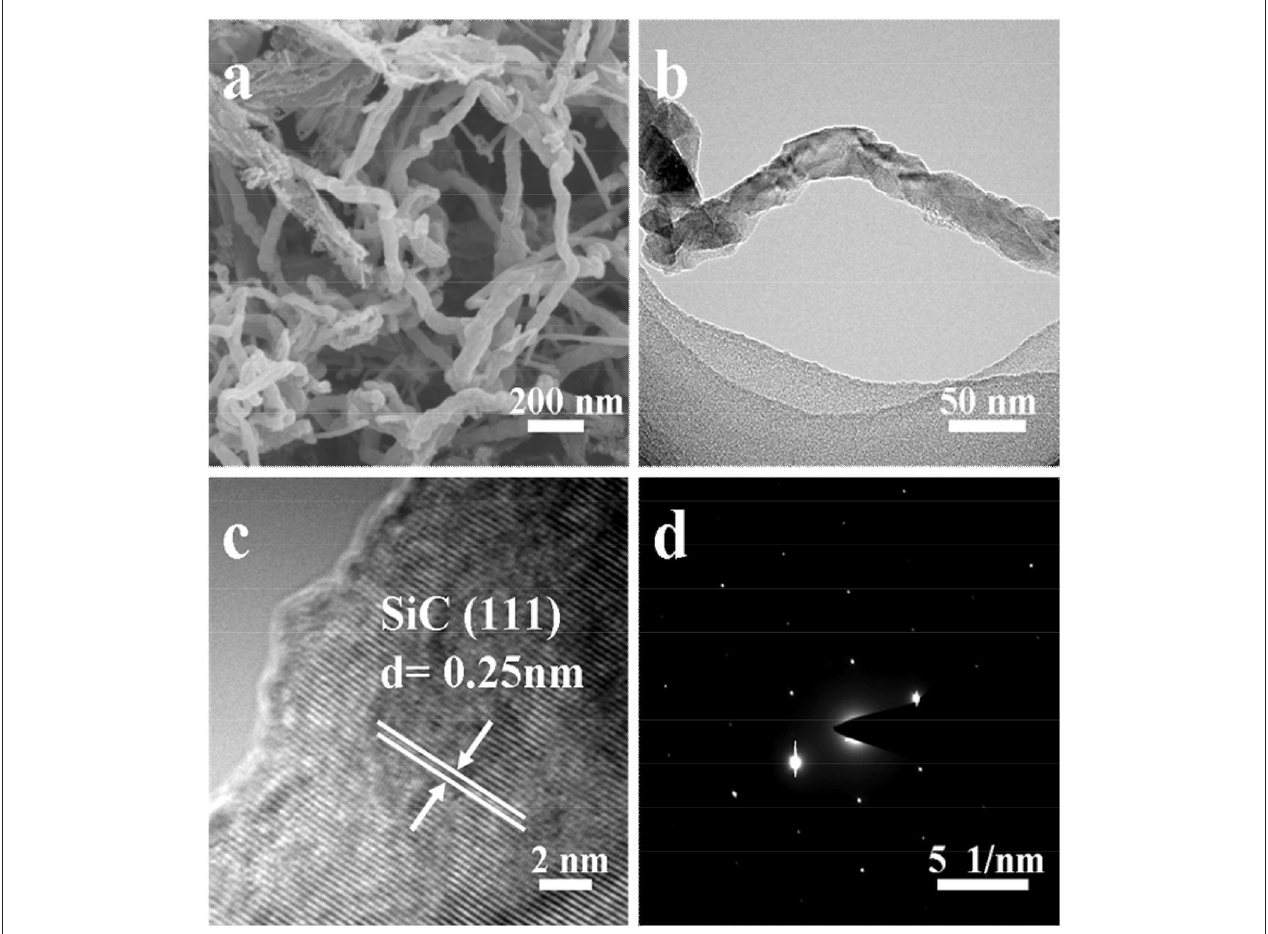
FIGURE 3 | (a) FE-SEM, (b) TEM and (c) HR-TEM images, and (d) SAED pattern of sample S2 .